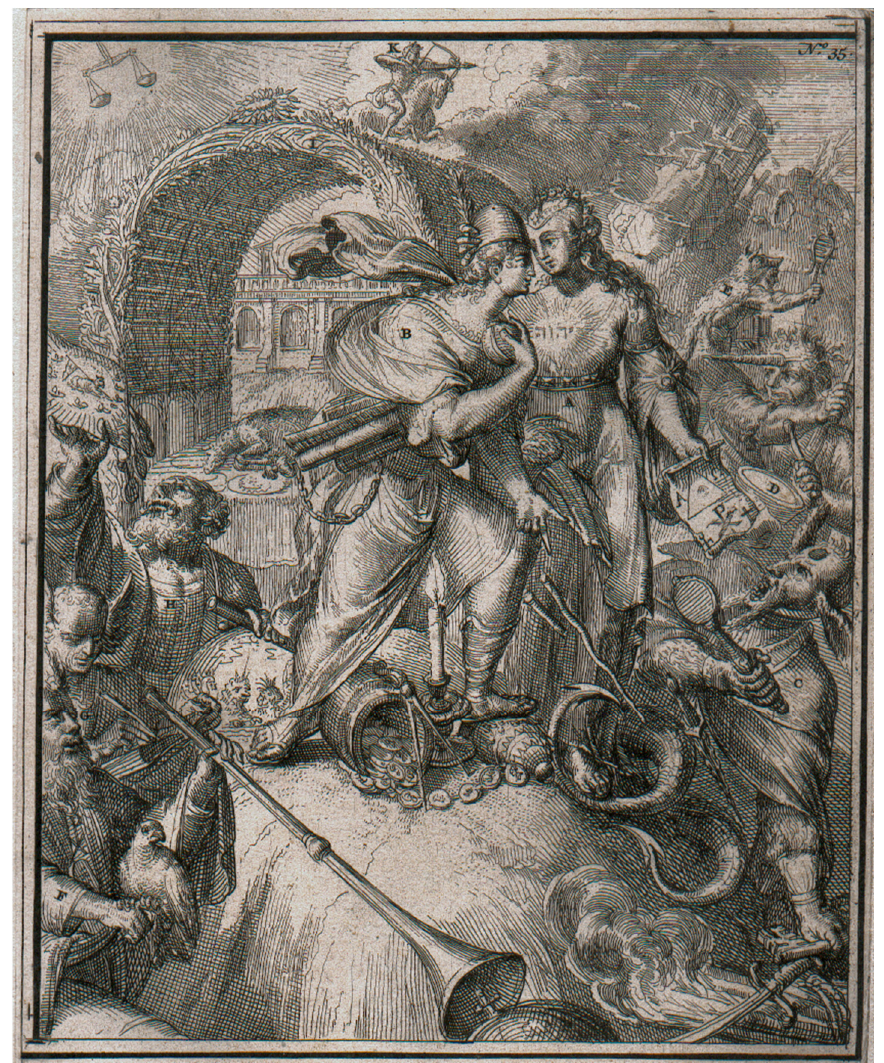
Figure 4. Plate 35, Van de Vrede van Gods Kerk (on the Peace of God’s Church), in Romeyn de Hooghe, Hieroglyphica . Private collection. Hieroglyphica . Private